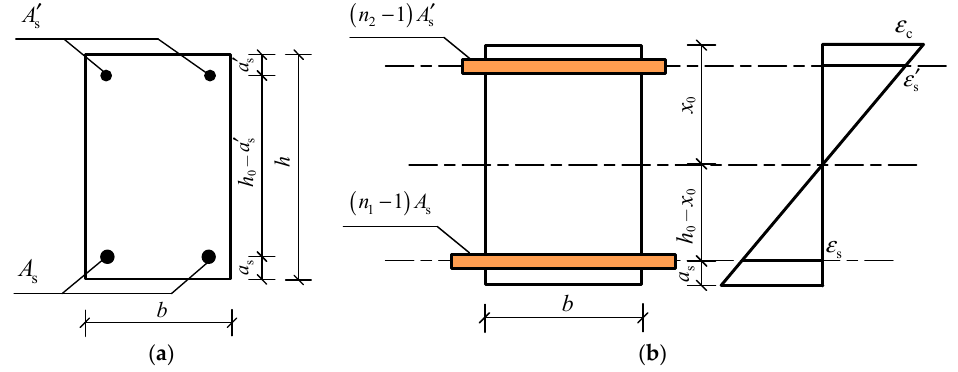
Figure 3. Transformed cross-section before concrete cracking. ( a ) Original cross-section; ( b ) transformed cross-section.